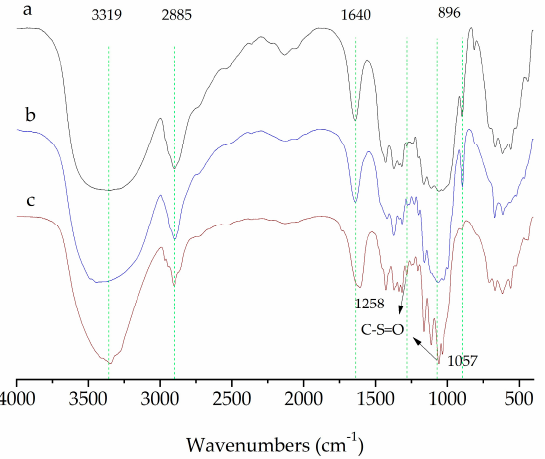
Figure 6. FTIR spectra of ( a ) the original MCC; ( b ) the CNCs extracted with swelling − SA − catalyzed hydrolysis method for 5 h at 45 °C; ( c ) the extracted CNCs hydrolyzed in 65.0 wt% H 2 SO 4 for 5 h at 45 °C .